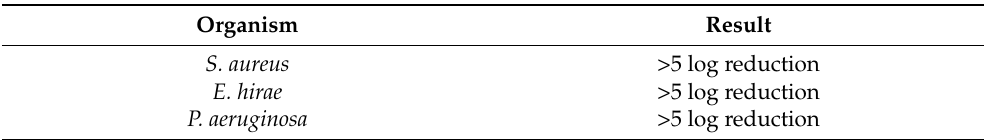
Table 8. Testing of the optimized 2:1 ratio (15.0 mg/mL GS-2 with 7.5 mg/mL thymol) under EN standard 13727:2012 + A2:2015; hospital-grade disinfectant with 5 min of exposure under dirty conditions. n = 3 technical replicates.